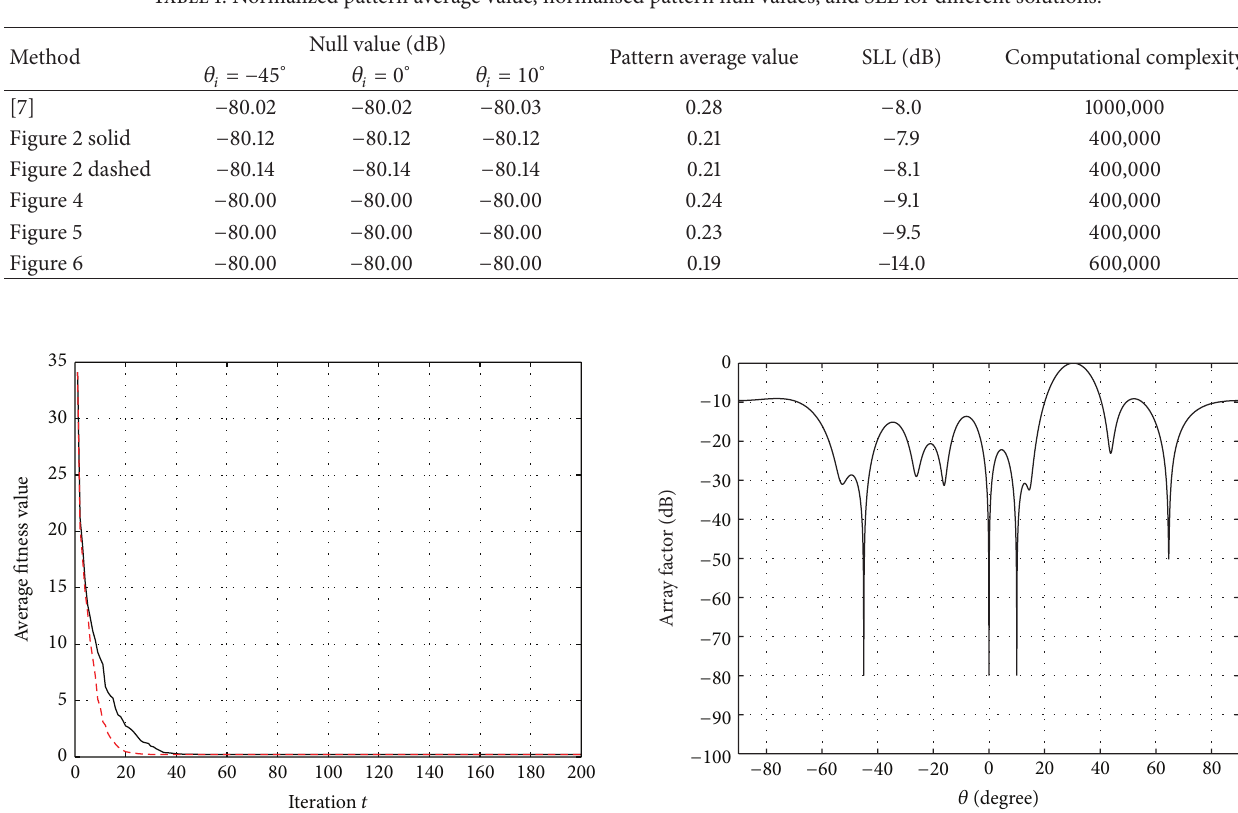
Figure 4: Resultant beam pattern designed ( 𝑁 = 10 ) by the feed- back function of (10).